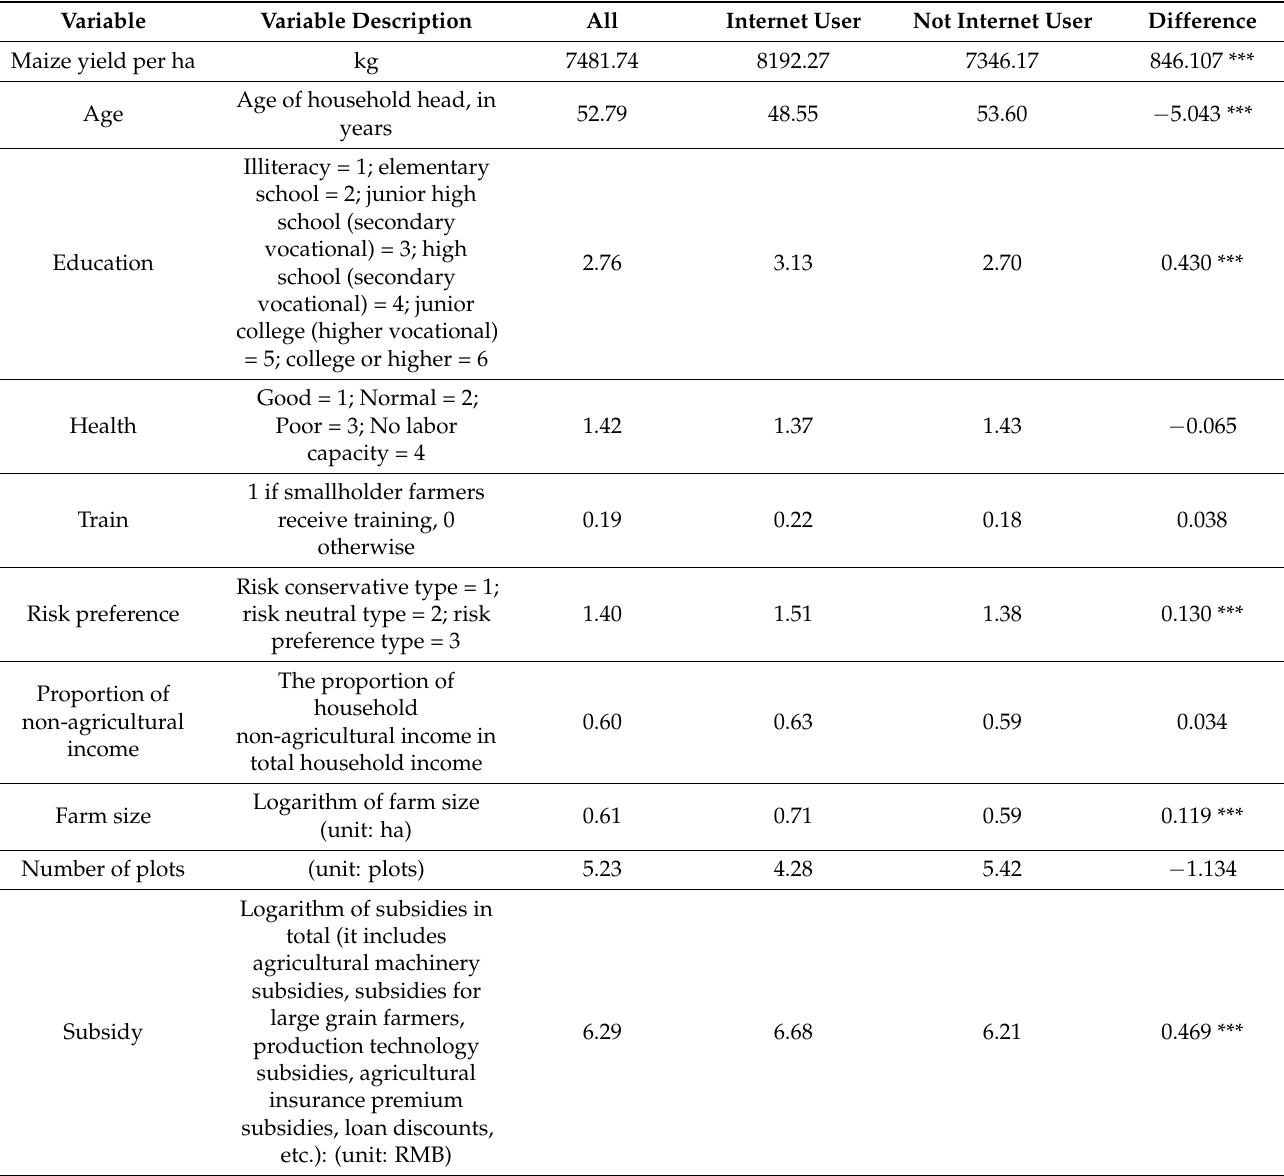
Table 2. Descriptive statistics of the